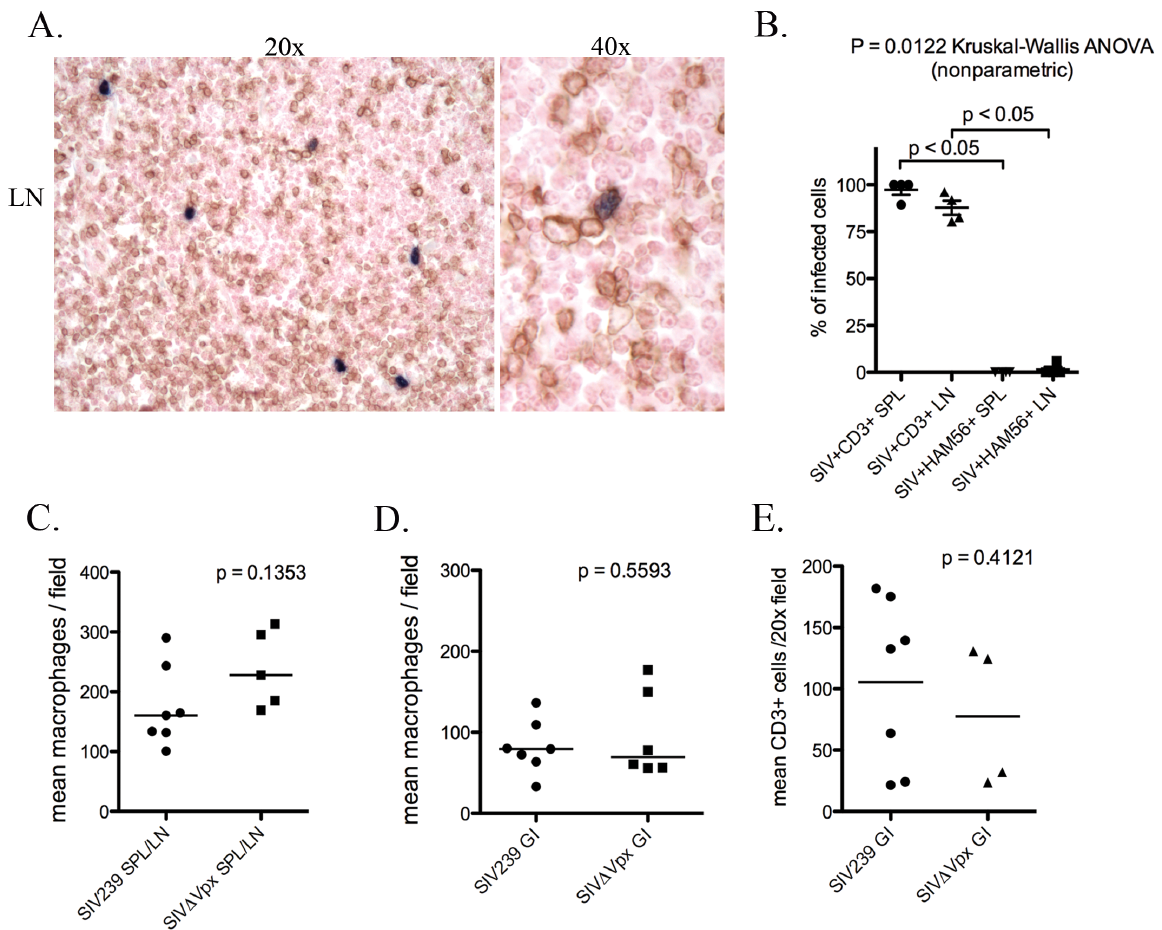
Figure 3. Quantification of tissue macrophages and lymphocytes in SIV D vpx compared to SIVmac239-infected rhesus. (A). Rhesus, lymph node: representative image of SIV in situ hybridization (ISH, blue) with double-label immunohistochemistry for CD3 + T lymphocytes (DAB, brown); (B). Quantification of immunophenotyped SIV D vpx -infected cells demonstrates almost exclusive infection of CD3 + T lymphocytes and not Ham56 + macrophages in spleen and lymph nodes (p , 0.05); (C). Numbers of Ham56 + tissue macrophages in the spleen or lymph node and colon were not significantly different in SIV D vpx -infected rhesus macaques compared to SIVmac239-infected rhesus; (D). Numbers of CD3 + lymphocytes were not significantly different in the colon in SIV D vpx -infected rhesus macaques compared to SIVmac239-infected